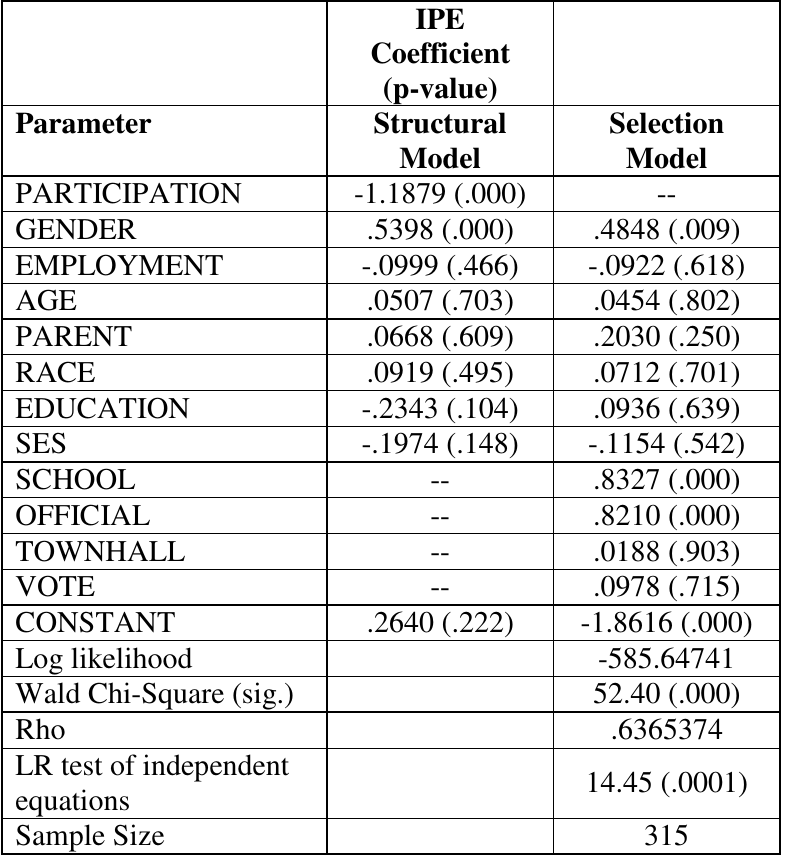
Table 3: TEM Results - IPE among Participants and Non-Participants at Time